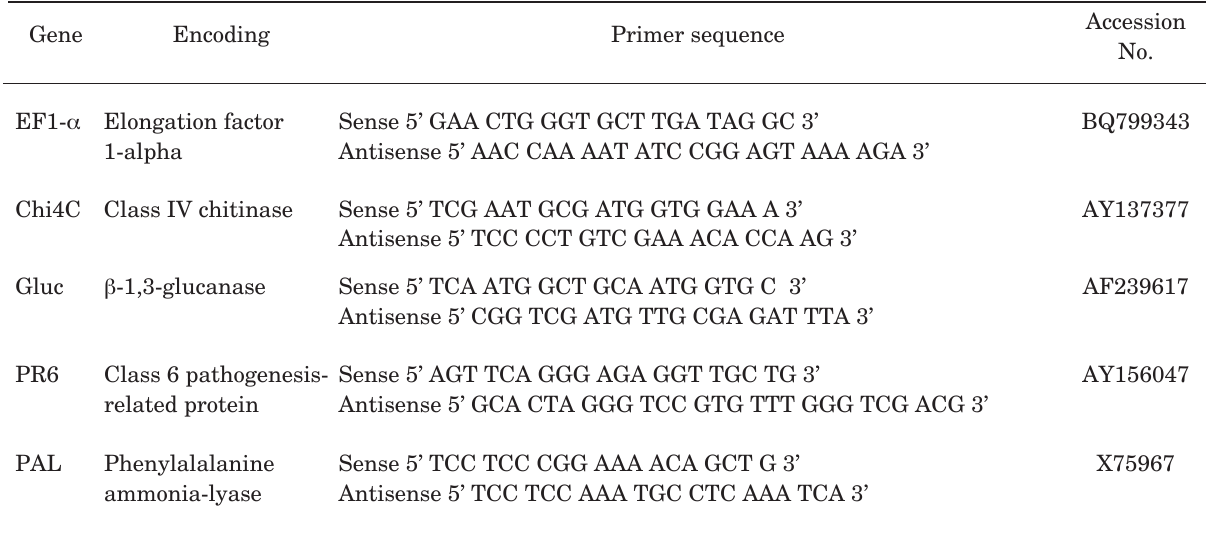
Table 2. Defence-related genes analyzed by real-time RT-PCR. The mRNa copy number of each sample was calculated from the standard curve using its Ct value and corrected by normalization against EF1 α mRNa (Terrier et al ., 2005).